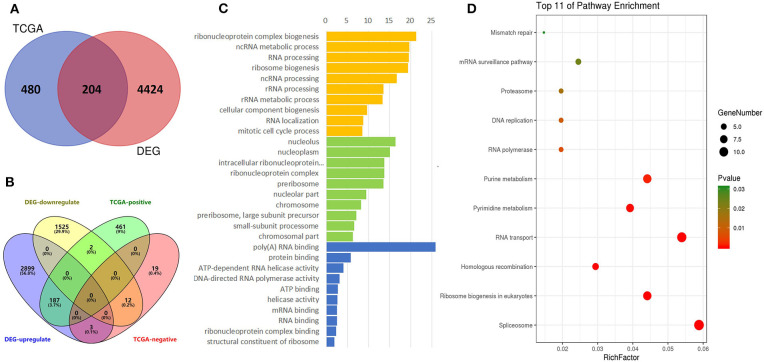
Identification of DEGs, gene ontologies (GOs), and KEGG pathways relevant to DDX56. (A) Venn diagram for selected identical DEGs and TCGA-relevant genes. (B) Four-dimensional Venn diagram for up/down-regulated DEGs and positive/negative-related TCGA genes. (C) Functional GO enrichment of DDX56-relevant DEGs. (D) KEGG pathway enrichment.